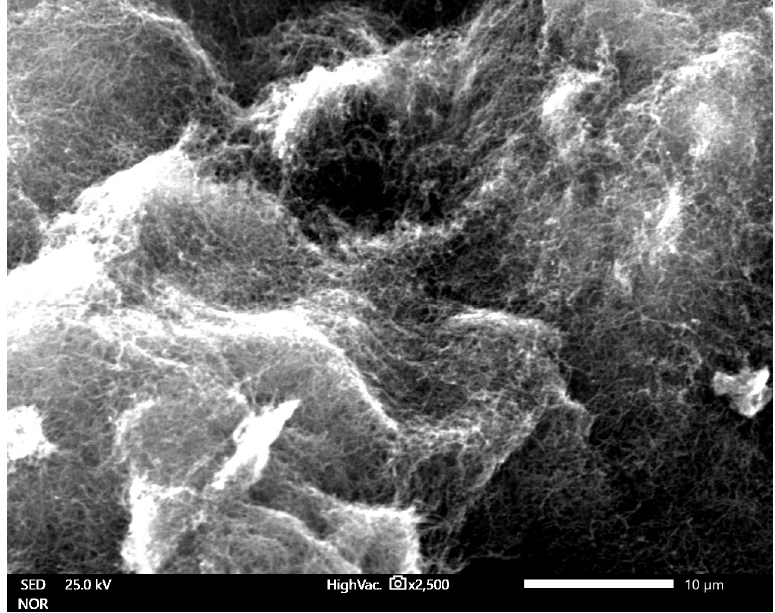
Figure 4. SEM image of ferromagnetic MWCNTs—sample no. 5 (low flow velocity).